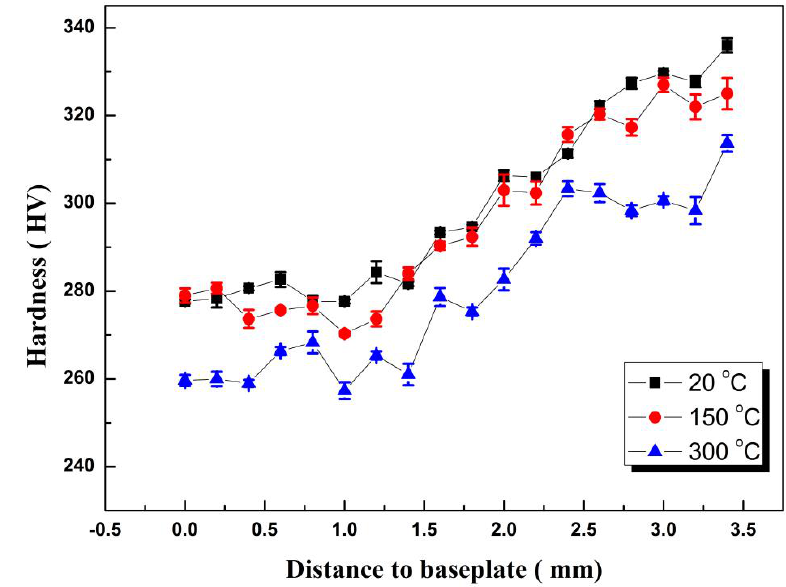
Figure 4. Hardness of different preheating